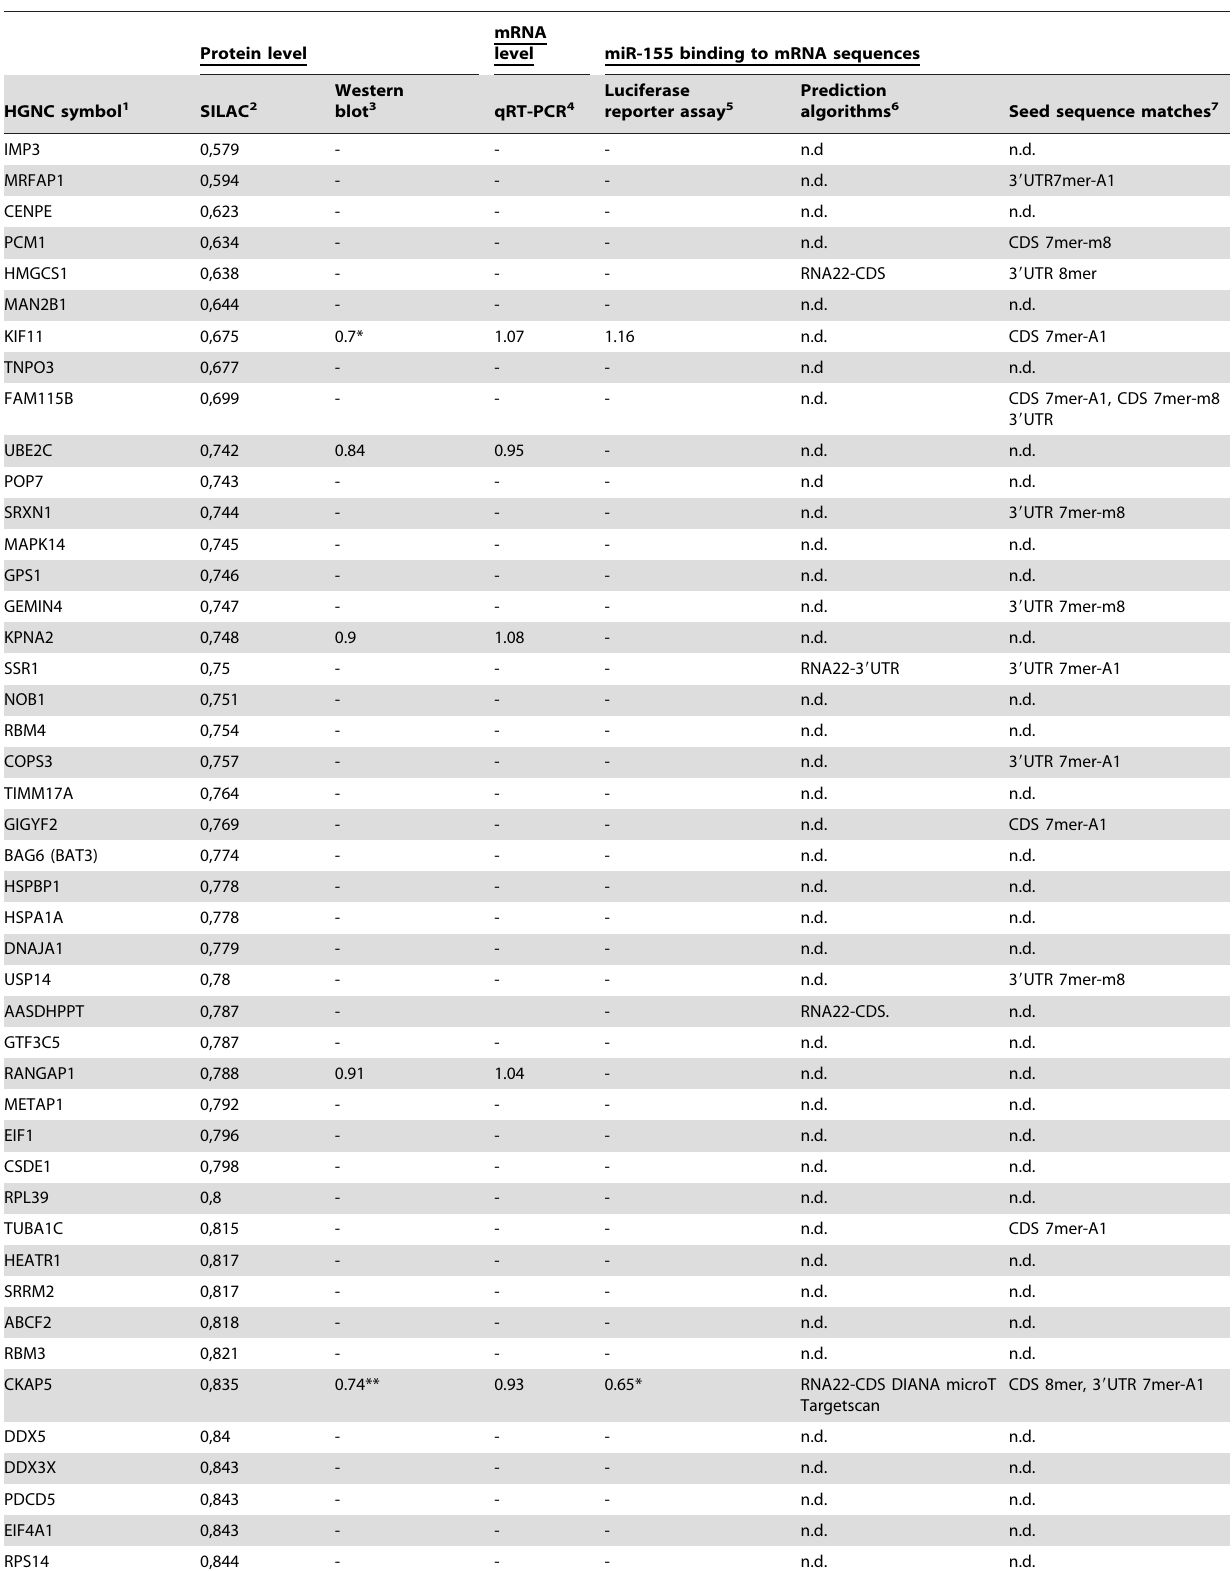
Table 1. Potential downregulated miR-155 target proteins in HEK293T cells detected by SILAC with supportive data (Western blot analysis, qRT-PCR, miRNA binding).